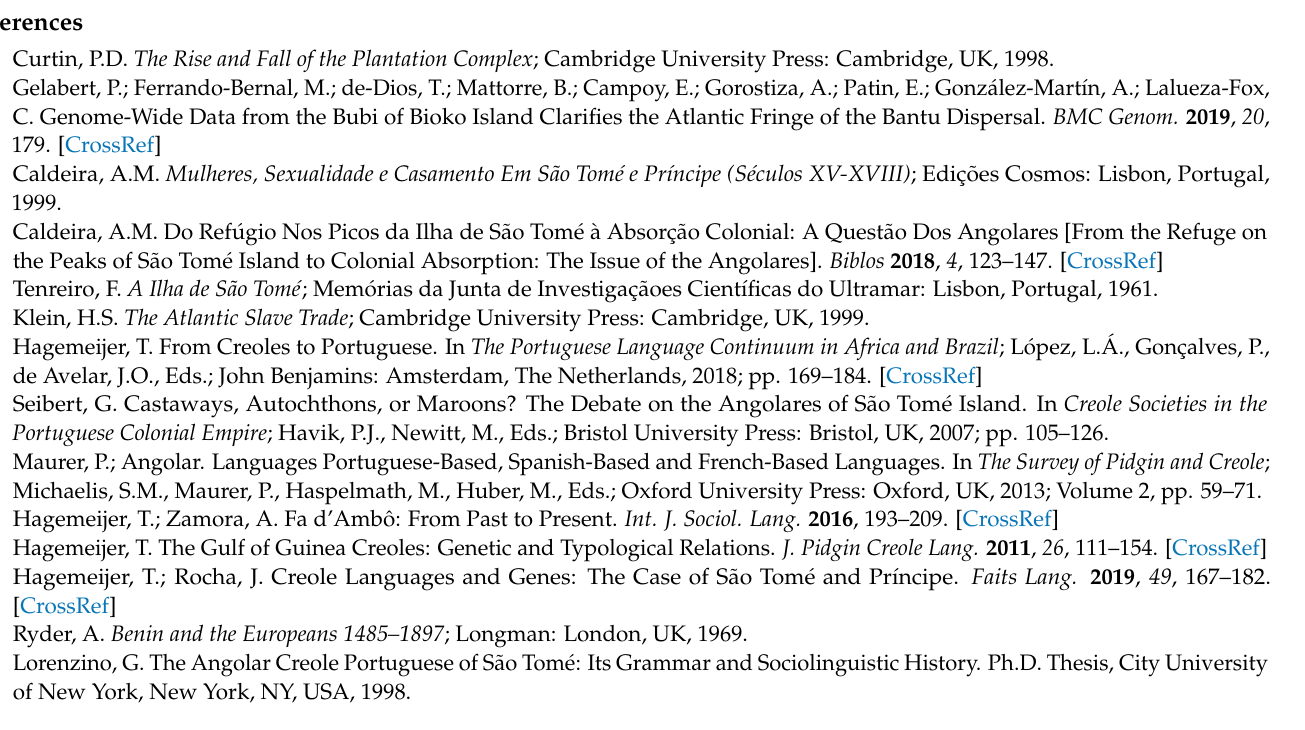
summary statistics of genetic diversity; Figure S10: mtDNA and Y-chromosome networks; Figure S11: Matching analysis; Figure S12: Frequency change in Y-chromosome descent cluster; Table S1: Geographic location, language affiliation and sample size of populations used in this study; Table S2: Ancestry estimates; Table S3: mtDNA variation in Pr í ncipe; Table S4: Y-chromosome variation in Pr í ncipe; Table S5: mtDNA diversity statistics; Table S6: Y-chromosome diversity statistics; Table S7: Y-chromosome haplotype sharing